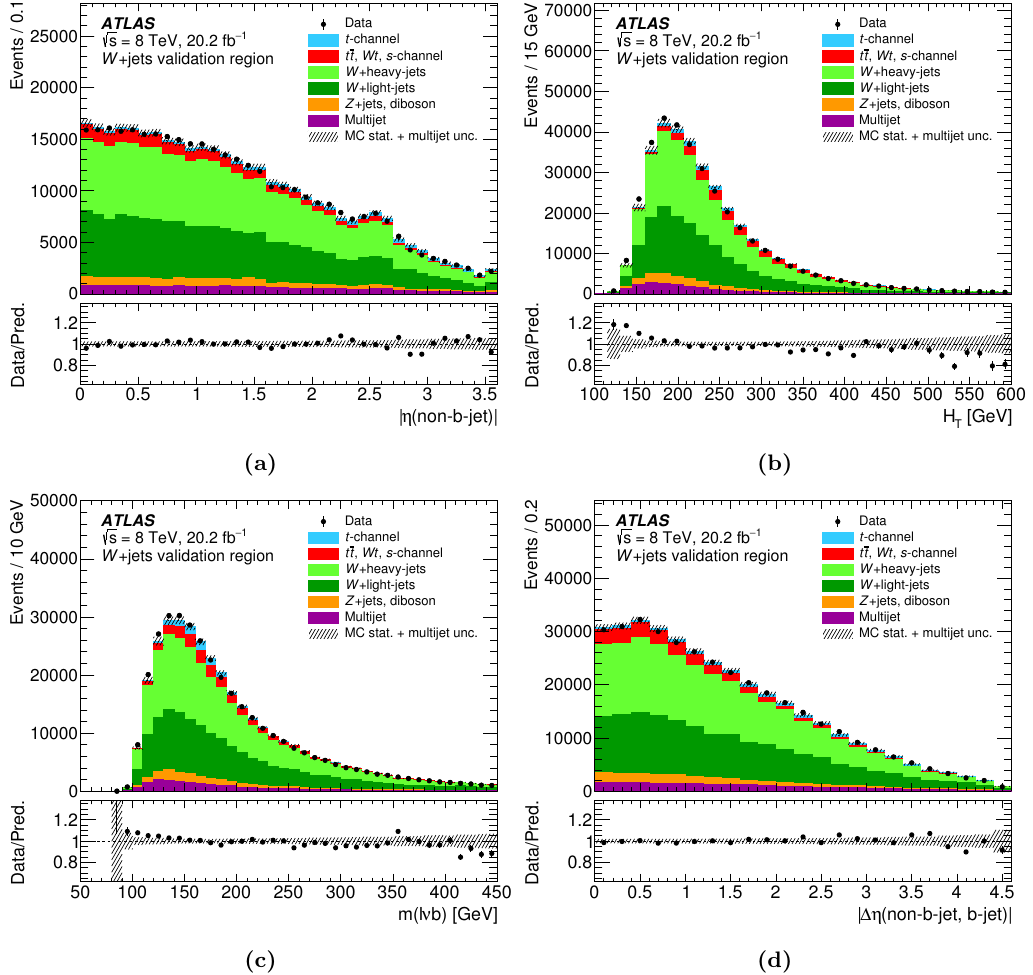
Figure 6. Distributions of (a) (cid:17) (non b -jet) , (b) the scalar sum of the p T of all (cid:12)nal-state objects, j j H T , (c) reconstructed top-quark mass, m ( ‘(cid:23)b ), and (d) (cid:1) (cid:17) (non b -jet ; b -jet) in the W +jets vali- j j dation region for the merged electron and muon channels. The multijet background is estimated using data-driven techniques, while contributions from simulated W +jets, top-quark backgrounds and t -channel event samples are normalised to the results of a maximum-likelihood (cid:12)t to event yields in the signal and control regions. The uncertainty bands correspond to the uncertainties due to the size of the simulated event samples added in quadrature with the data-driven normalisation uncertainty of 70% estimated for the multijet contribution. The lower plots show the ratio of data to prediction in each